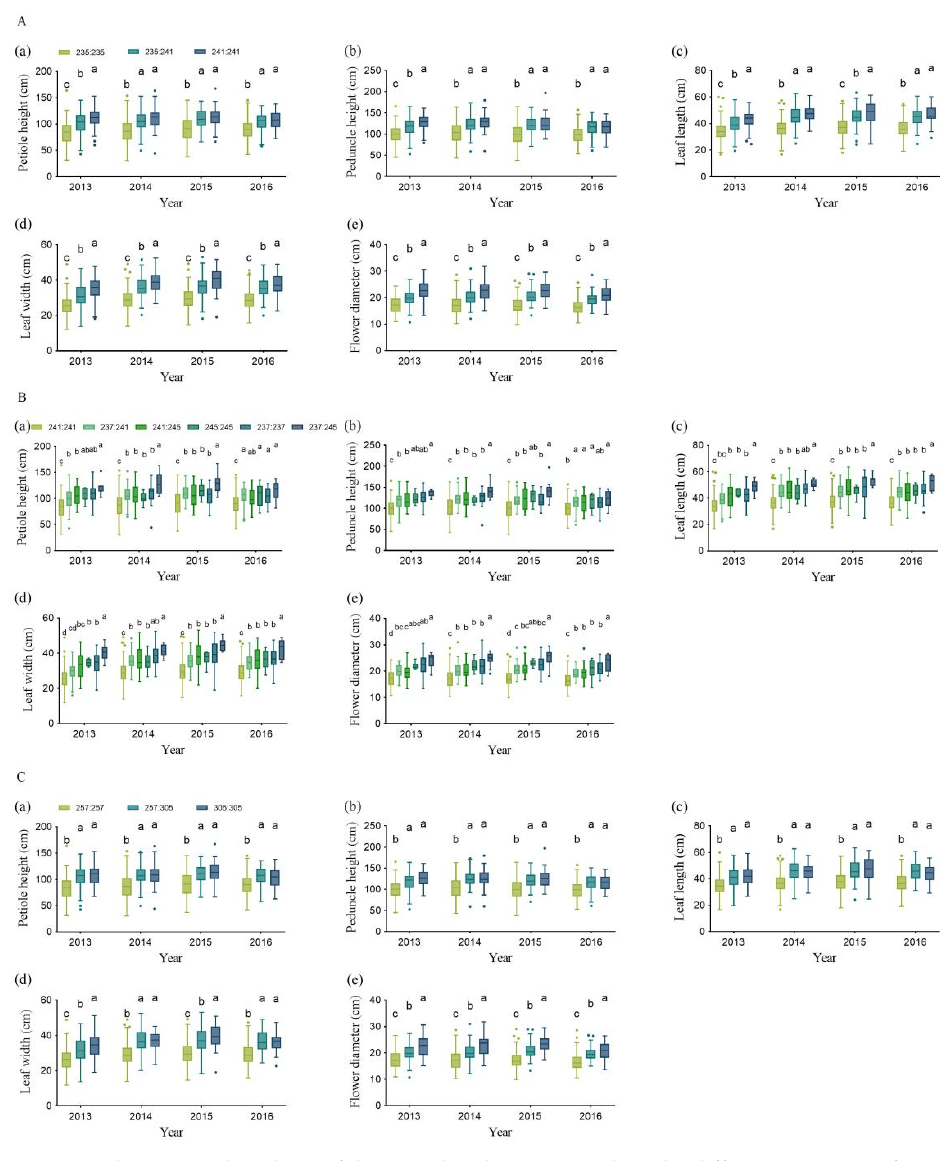
Figure 4. Phenotypical analysis of the PA-related traits regarding the different genotypes from 2013 to 2016. Three, six, and three genotypes were present, corresponding to NNIndel_99 ( A ), SSR67 ( B ), and NNIndel_81 ( C ), respectively. ( a – e ) represent the five PA-related traits. Different letters in lower case on the top of the bars indicate significant differences at p < 0.05 tested by DunCan multiple-range test using SPSS.